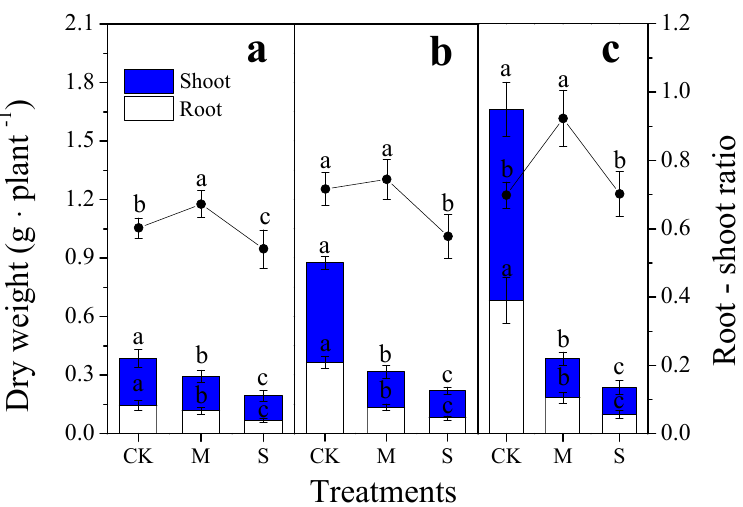
Figure 2. Effects of different drought treatments on the root–shoot ratio and on the dry weight of roots and shoots during different periods. The different lowercase letters denote significant differences between treatments ( p < 0.05). The histogram represents the dry weight of the roots and shoots, and the line chart represents the root–shoot ratio. ( a ): 30th day; ( b ): 60th day; ( c ): 90th day. CK: control; M: moderate drought; S: severe drought. The same below.